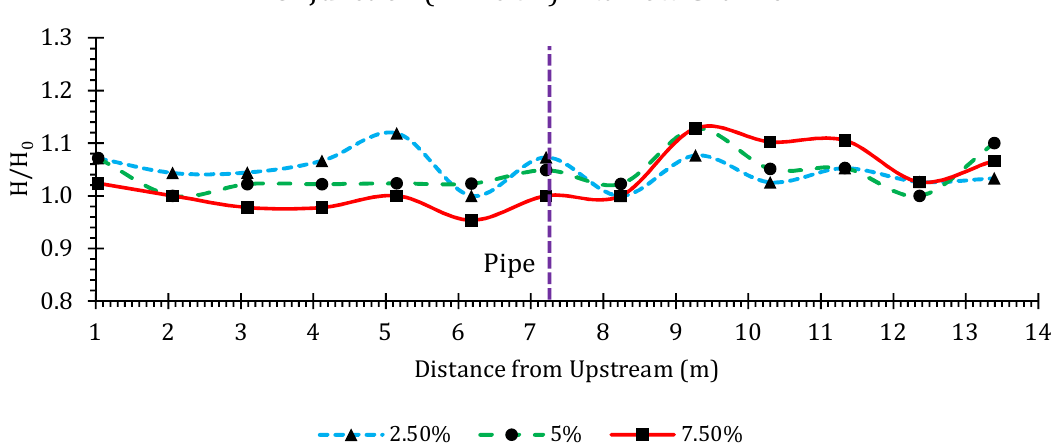
Figure A23. Water height ratios in a 45 ◦ junction for Fr = 0.72 in the narrow Figure A23. Water height ratios in a 45° junction for Fr = 0.72 in the narrow channel. Figure A23. Water height ratios in a 45° junction for Fr = 0.72 in the narrow channel. Figure A23. Water height ratios in a 45° junction for Fr = 0.72 in the narrow channel.